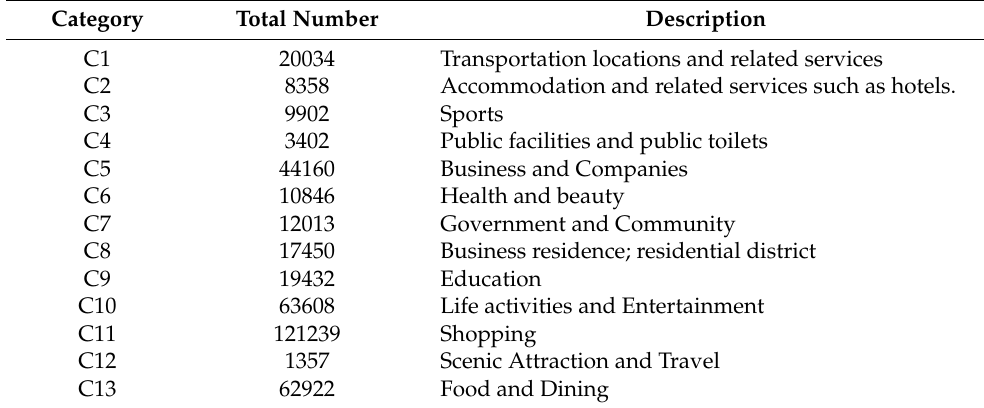
Figure 2. ( a ) Road network, ( b ) Main regions of the city of Wuhan. Table 2. Description of POIs categories in the city of